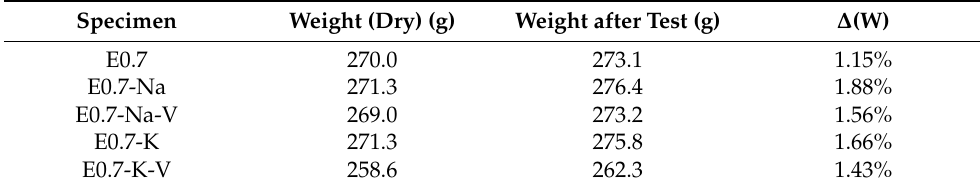
Table 7. Wet chamber test results weight variation.